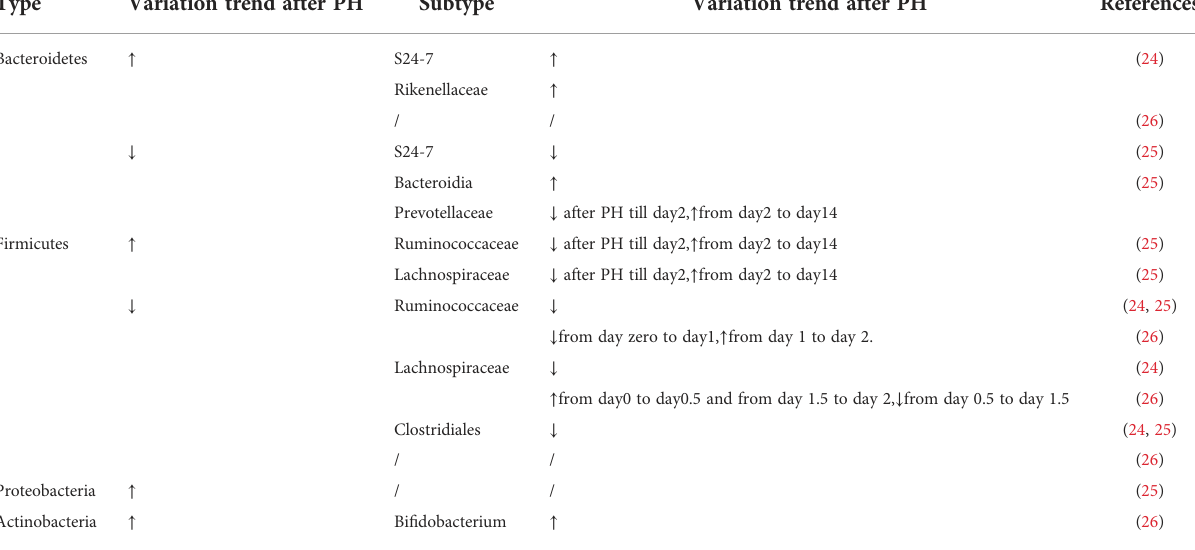
TABLE 1 The variation trend of different type of gut microbiota after PH.